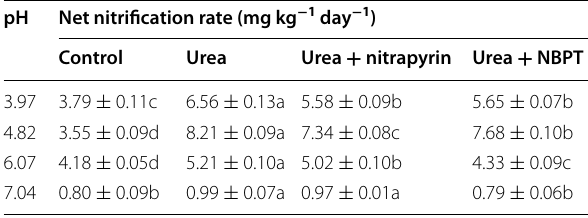
Values are mean or mean row followed by the different letters indicate significant difference ( P < 0.05)